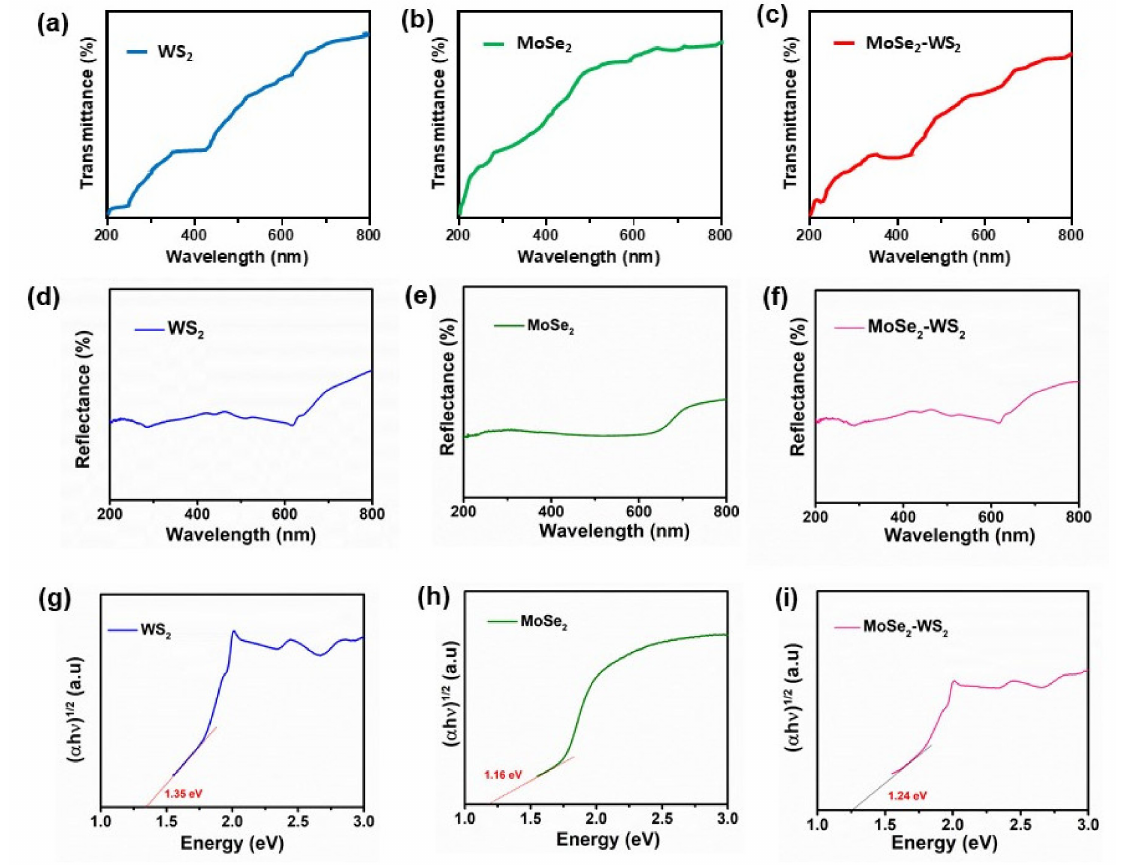
Figure 6. Determination of the bandgap of WS 2 , MoSe 2 and MoSe 2 -WS 2 catalysts. ( a – c ) UV-Vis transmittance spectra, ( d – f ) UV-Vis reflectance spectra and ( g – i ) Tauc’s